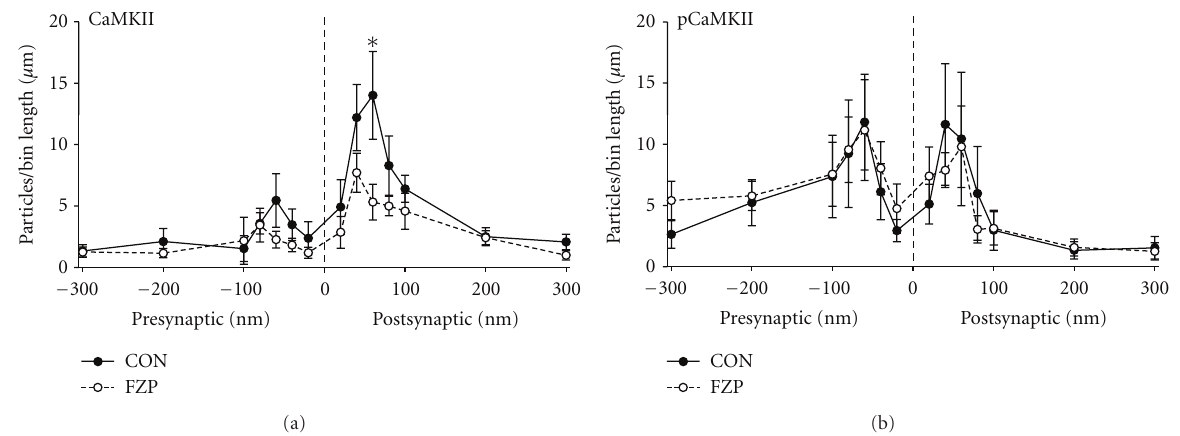
Figure 2: Pre- and postsynaptic distribution of CaMKII and pCaMKII immunogold particles in CA1 asymmetric synapses of control and FZP-withdrawn rats. (a) Analysis of CaMKII postsynaptic labeling revealed a significant interaction between experimental group and binned distance ( P < 0 . 05, F(6,48) = 3 . 13, two-way repeated measures ANOVA) with significantly decreased CaMKII labeling 60 nm postsynaptic to the PSD membrane in FZP-withdrawn relative to control synapses (CON: 14 . 01 ± 3 . 57 particles/ μ m, n = 5; FZP: 5 . 32 ± 1 . 45 particles/ μ m, n = 5; P < 0 . 01, Bonferroni’s posttest). In contrast, no significant interaction between treatment and binned distance was observed for presynaptic CaMKII ( P = 0 . 34, F(6,48) = 1 . 16, two-way repeated measures ANOVA). (b) There was no significant interaction between experimental group and binned distance for pre- ( P = 0 . 96, F(6,38) = 0 . 25) or postsynaptic pCaMKII labeling ( P = 0 . 78, F(6,48) = 0 . 53, two-way repeated measures